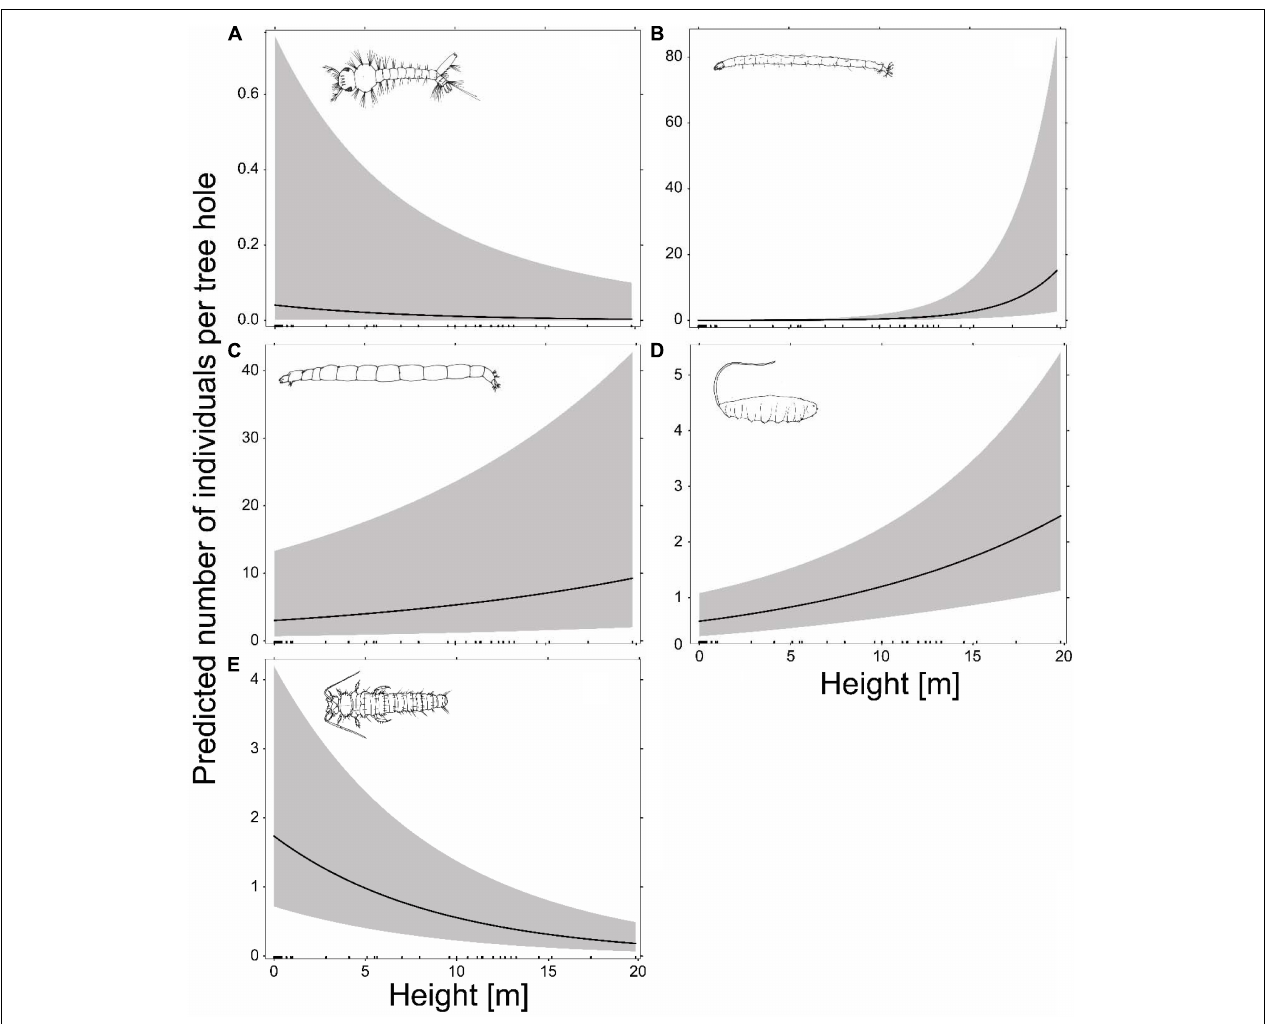
FIGURE 4 | Prediction of the abundance of the most abundant species in our study as a function of tree-hole height above ground, based on generalized linear mixed effects models with a Poisson distribution, including tree-hole-scale and plot-scale variables (for tree-hole density canopy and ground holes were combined) as additional predictors. The gray bands show 95% confidence intervals. The bars on the x-axis indicate the tree holes sampled along the vertical gradient. (A) Diptera, Culicidae: Aedes geniculatus occurrence in n = 88 tree holes; (B) Diptera, Ceratopogonidae: Dasyhelea sp., n = 109; (C) Diptera, Chironomidae: Metriocnemus cavicola , n = 194; (D) Diptera, Syrphidae: Myiatropa florea , n = 139; (E) Coleoptera, Scirtidae: Prionocyphon serricornis , n =